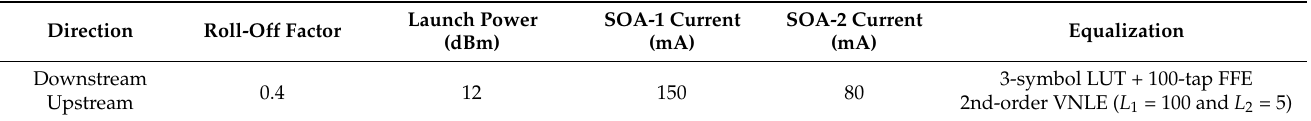
Table 1. Key parameters in the system.